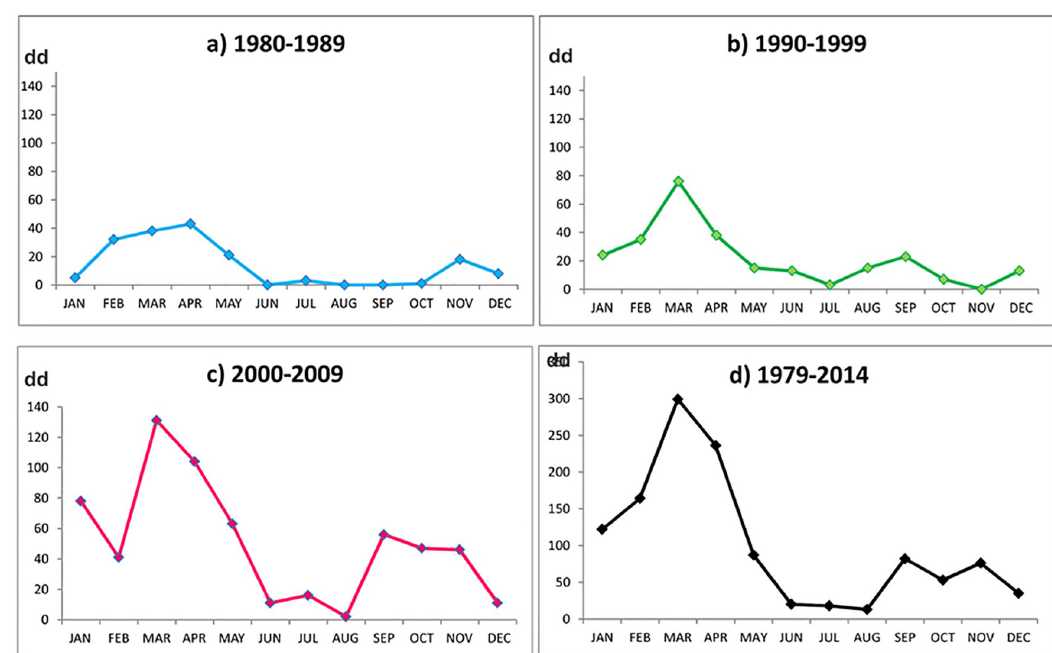
Fig 6. Monthly distribution of days of discolorations (dd) per decade (a, b and c) and d) the total of the 35 years recorded in Mazatlan Bay (1979–2014).